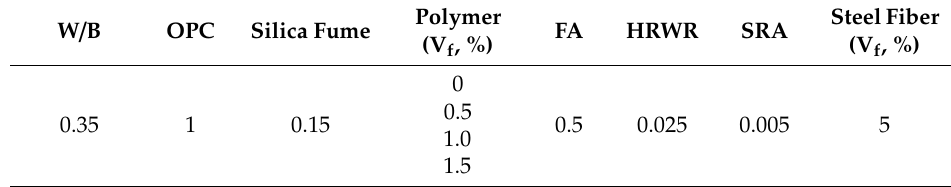
Table 1. Mix proportion ratio.